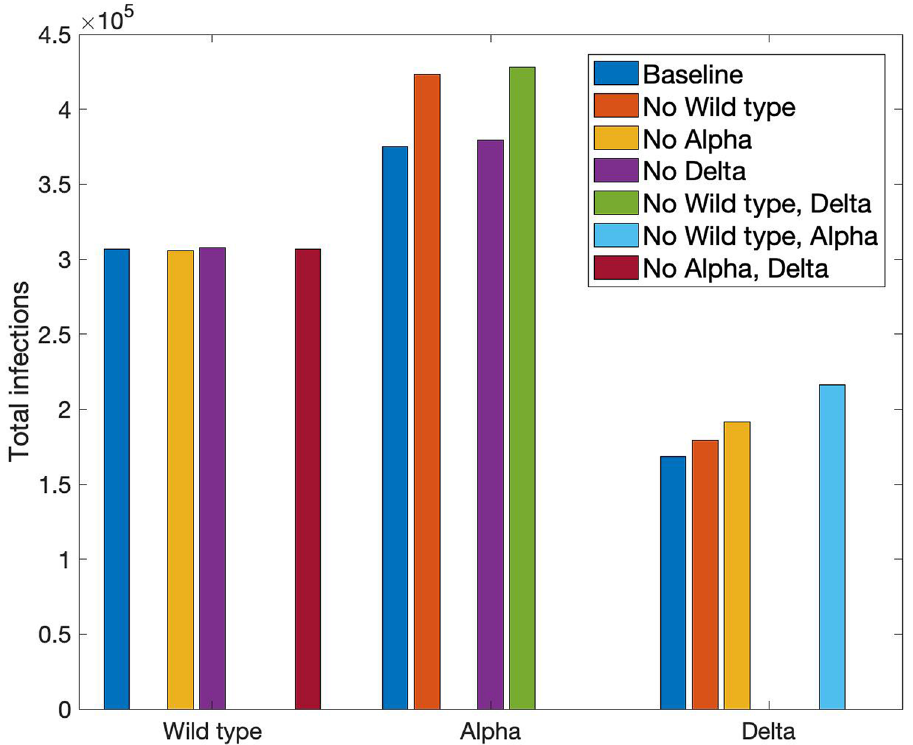
Figure 6. Predicted number of COVID-19 infections when some of the other variants are not in play. Results suggest that wild type limits the spread of Alpha; wild type and Alpha together limit